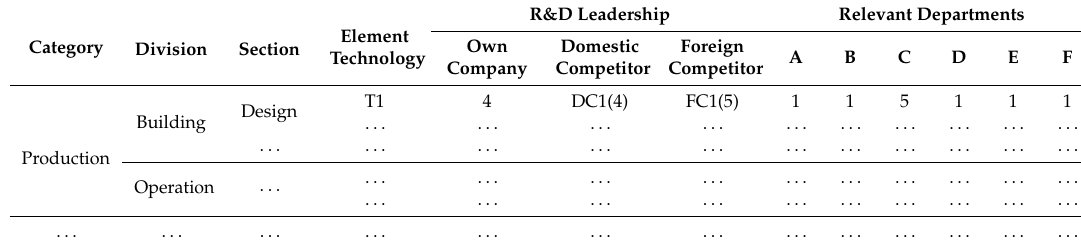
Table 8. Technology tree